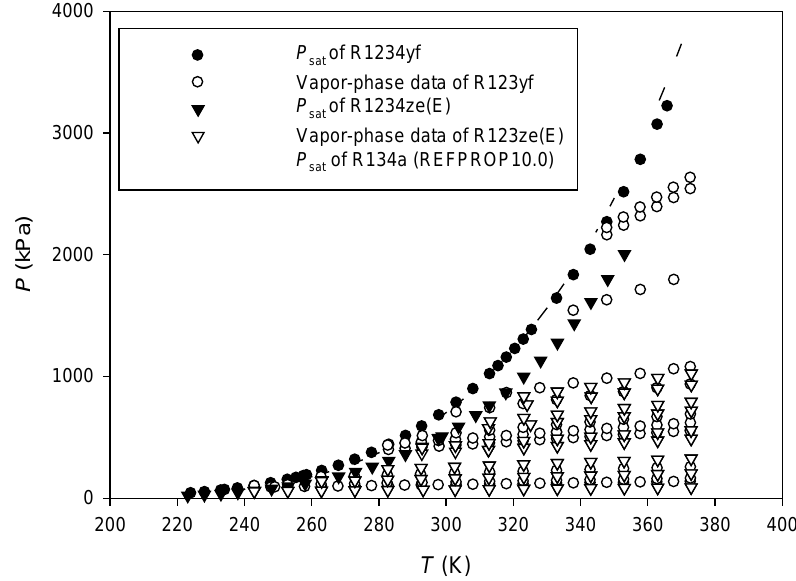
Figure 3. Vapor pressure ( P sat ) and PvT data in the superheated vapor phase measured with the isochoric apparatus for R1234yf and R1234ze(E). The vapor pressure of R134a calculated from REFPROP 10.0 is reported.